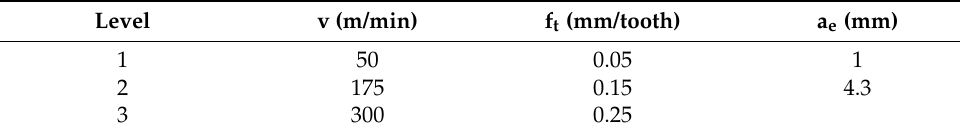
Table 2. Level values for each plan of experiments’ variable.